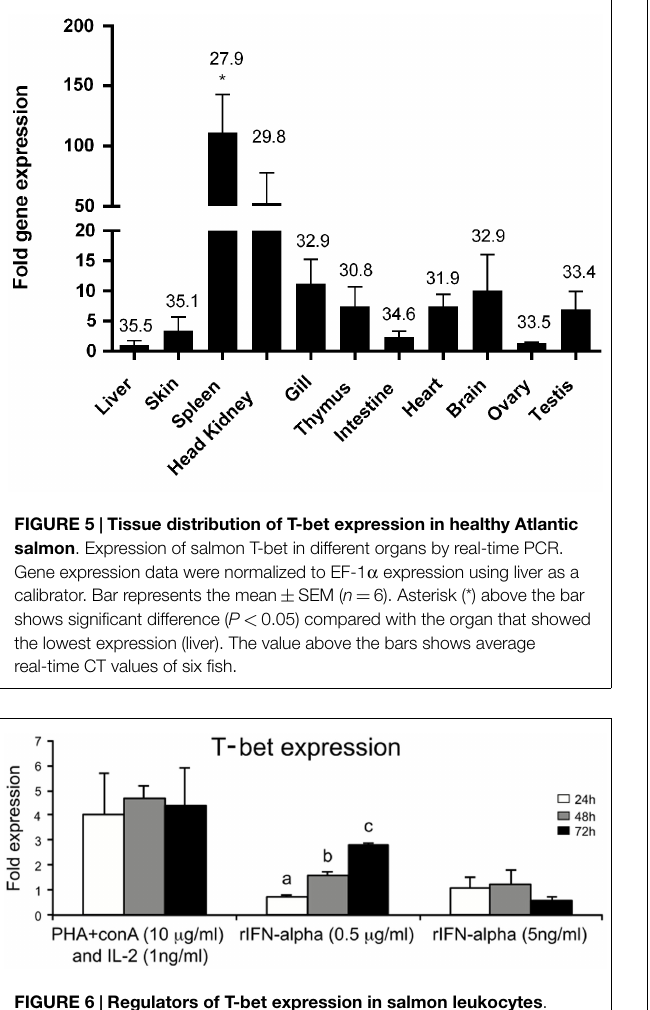
FIGURE 6 | Regulators of T-bet expression in salmon leukocytes . Spleen leukocytes were stimulated for 24, 48, and 72h with ConA + PHA + huIL-2, IFN- α (0.5mg/ml and 5ng/ml), and the mRNA levels of T-bet were determined by real-time PCR. Gene expression is normalized against EF-1 α and is shown relative to the mean of the non-stimulated cells (leukocyte cells with no treatment, i.e., only media control). Spleen leukocytes with no treatment were considered as control for each time points. Each bar represents the mean ± SE of triplicate samples. Different letters denote statistically significant differences ( P < 0.05) between the groups. FIGURE 7 | Tissue specific expression of T-bet, IL-22, NKEF, and IFN γ